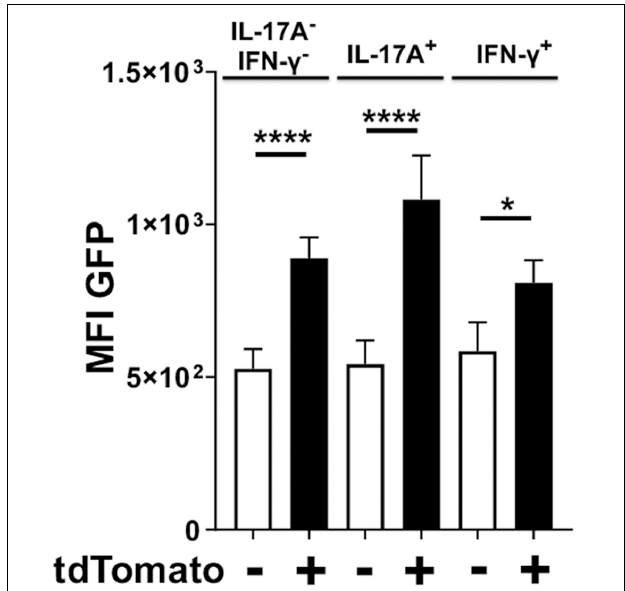
FIGURE 7 | Foxp3 cre -tdTomato + Treg cells producing IL-17A have an active Foxp3 promoter. Foxp3 cre -tdTomato + CD4 + Treg cells from the oral mucosa were identified by flow cytometry (gated as CD3 + CD4 + tdTomato + B220 − CD8 α − ). As the GFP signal in these mice was weak, anti-mouse FoxP3-Alexa488 was added during intracellular staining to increase the Foxp3 signal. The mean fluorescence intensity (MFI) of Foxp3-dependent green fluorescent protein (GFP) in populations of tdTomato − (white bars) and tdTomato + cells (black bars) from 20 mice are compared and presented for cells expressing IL-17A, IFN- γ or neither of the two cytokines. The GFP MFI was compared by fitting a mixed effects model with paired values. A post hoc Sidak’s multiple comparisons test was utilized to determine p -values of comparisons found significant by the initial mixed-effects analysis. * p < 0.05, **** p <